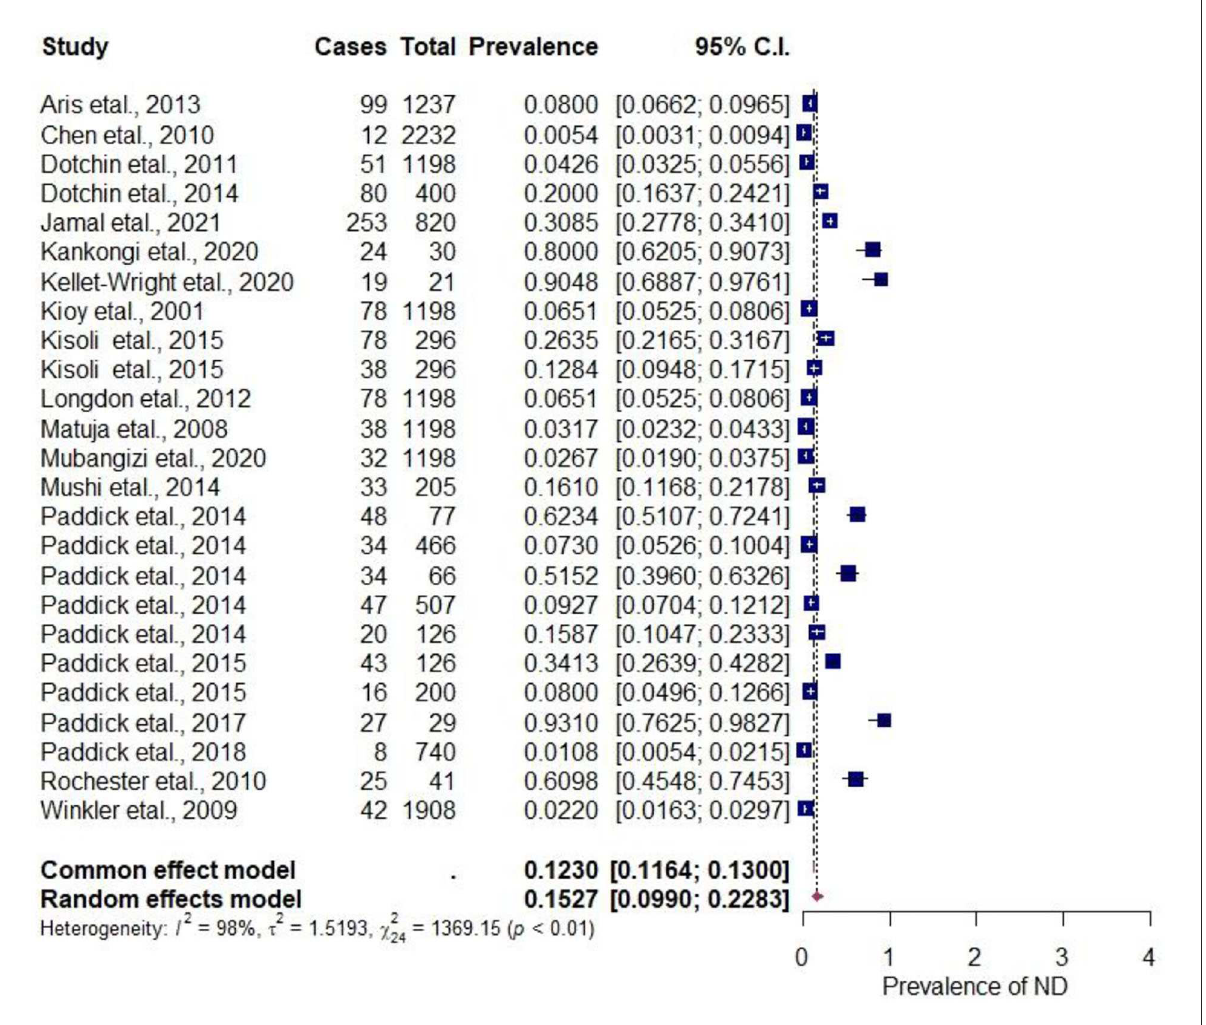
FIGURE2 Forest plot for the prevalence of NDs in the regional-based